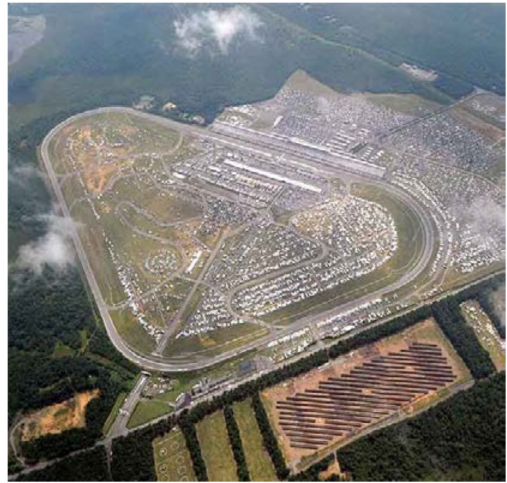
Figure 7. Triple Curve. (Pocono